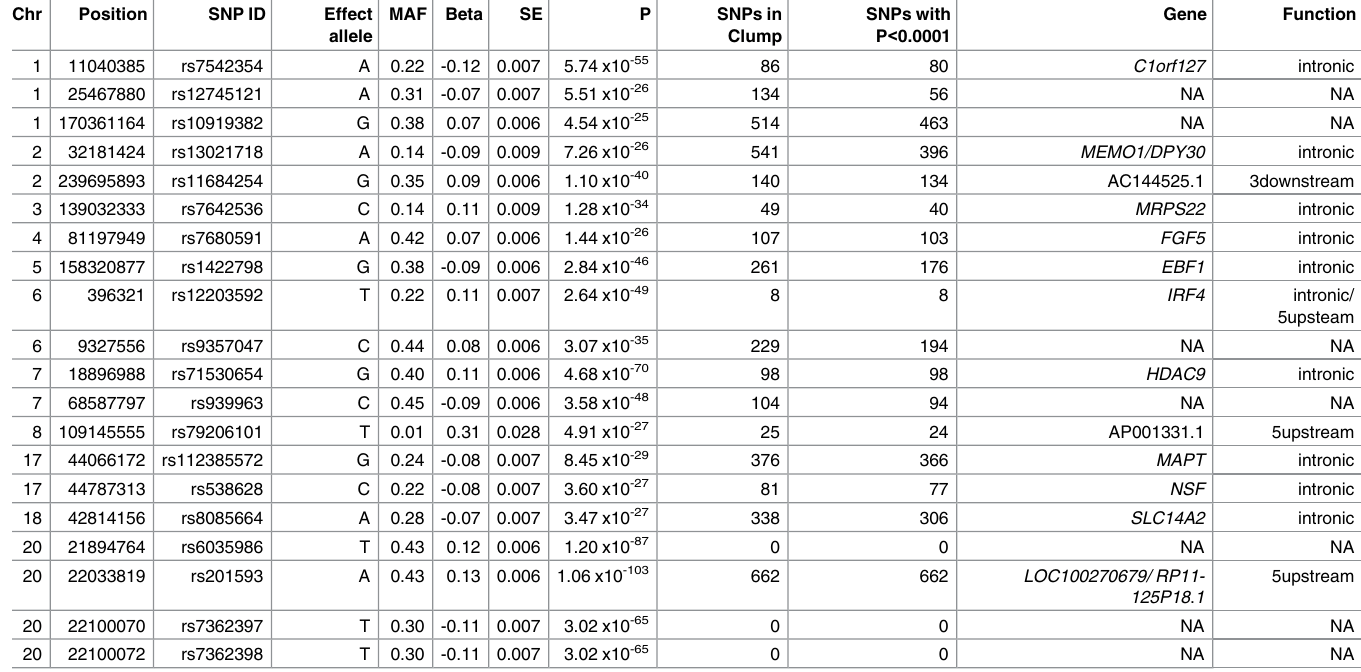
Table 1. Top 20 independent autosomal GWAS hits.